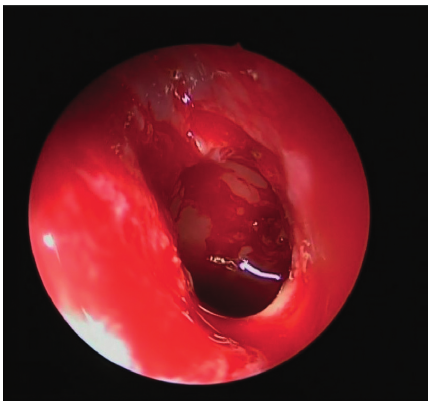
Figure 7: Postoperative endoscopic view showing wide sphenoi- dectomy post removal of fungal debris.